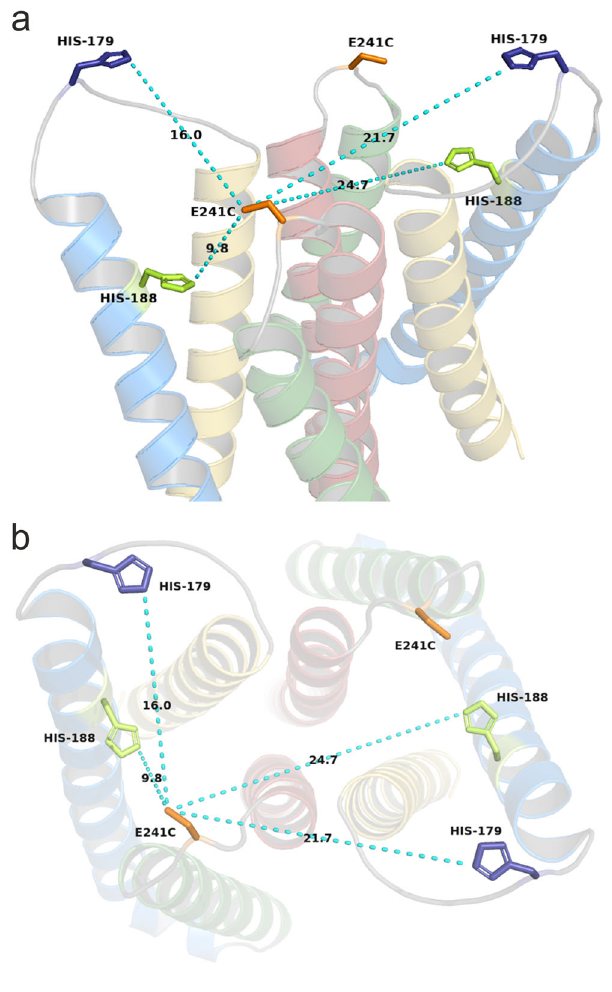
Fig. 4 Distances in the homology model of Ci-Hv1. The homology model of the S1-S4 voltage-sensing domains for Ci-Hv1 is based on the reported model 45 . Helices are color coded as follows: S1 (yellow), S2 (blue), S3 (green), S4 (red). E241C mutation is highlighted in orange, histidine residues at position 179 is represented in blue, while at position 188 is light green. a panel shows a side-view, ( b ) panel is a top-view. The light blue dashed lines represent the distances between E241C and His residues in the same subunit and in the other subunit. Black numbers on the light blue dashed lines show the distance in angstroms. These panels were created with Pymol 46